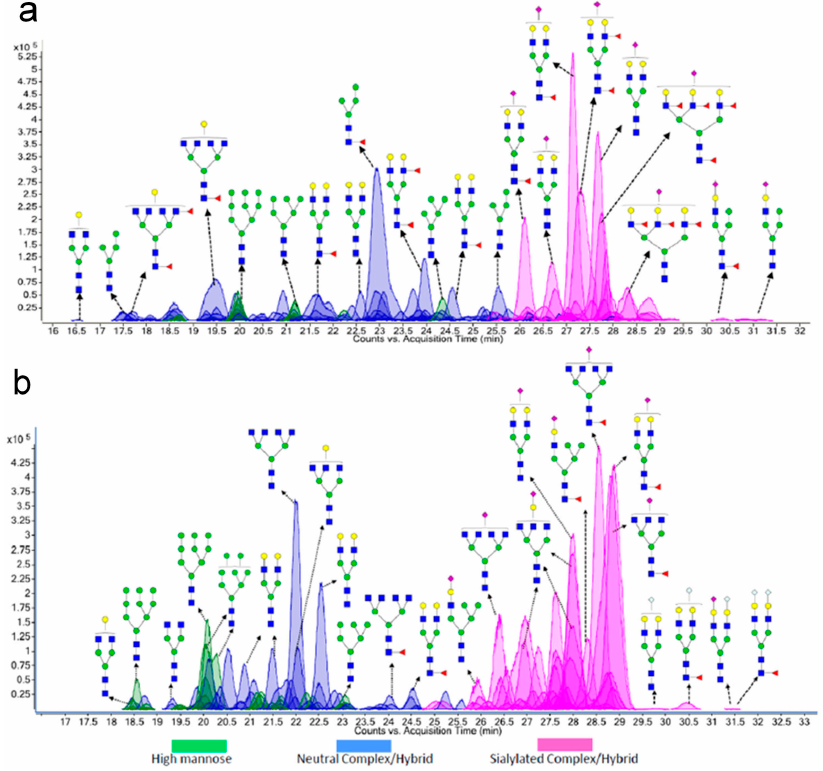
Figure 16. Extracted compound chromatograms (ECC) from nanoLC-MS runs showing the elution profiles of: ( a ) human milk N -glycans; ( b ) bovine milk N -glycans. Green circles, yellow circles, blue squares, red triangles, purple diamonds and grey diamonds represent Man (mannose), Gal (galactose), GlcNAc ( N -acetylglucosamine), Fuc (fucose), NeuAc ( N -acetylneuraminic acid) and NeuGc ( N -glycolylneuraminic acid), respectively. Reproduced with permission from [79]. Copyright American Chemical Society, 2012.